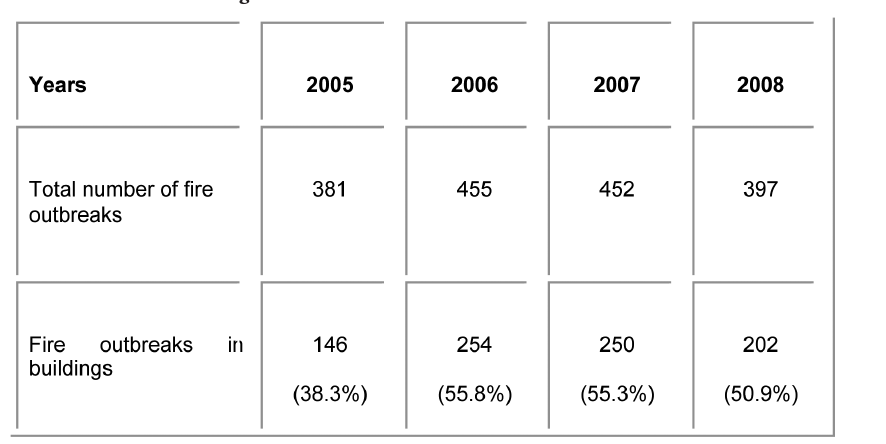
Table 1. Fire outbreaks in buildings in Dar es